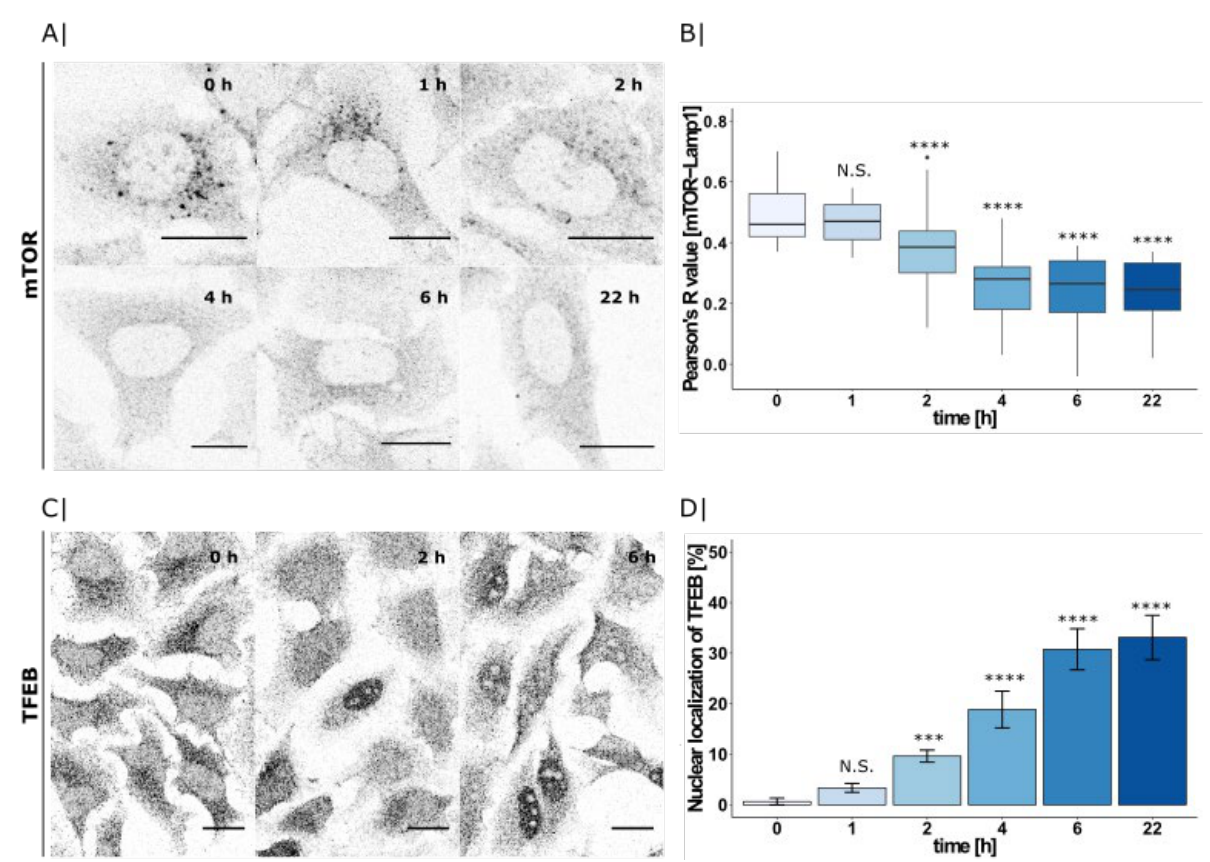
Figure 4. PDMP time-course and its effect on mTOR and TFEB translocation. ( A ) HeLa WT cells treated with PDMP (20 µ M) for 0–22 h and mTOR visualized by immunofluorescence using mTOR-antibody. Scale bar indicates 20 µ m. ( B ) Co- localization with Lamp1 was quantified by calculating Pearson’s R value between mTOR and Lamp1 for each timepoint (0 h: n = 29 cells, 1 h: n = 28 cells, 2 h: n = 46 cells, 4 h: n = 41 cells, 6 h: n = 32 cells, and 22 h: n = 32 cells) and presented as boxplots. Center lines show the median; box limits indicate first (Q1) and third quartiles (Q3); and whiskers extend to